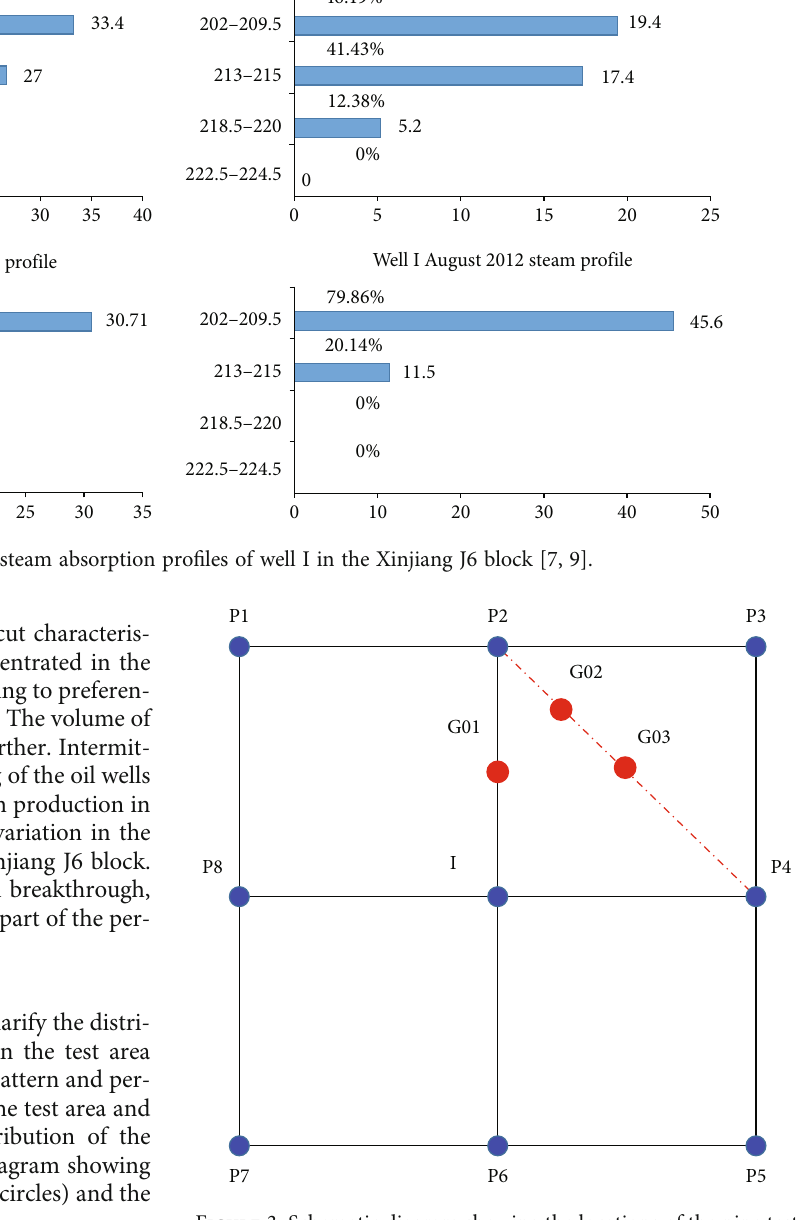
Figure 3: Schematic diagram showing the locations of the nine test wells (solid blue circles) and the three cored wells (solid red circles) [7,